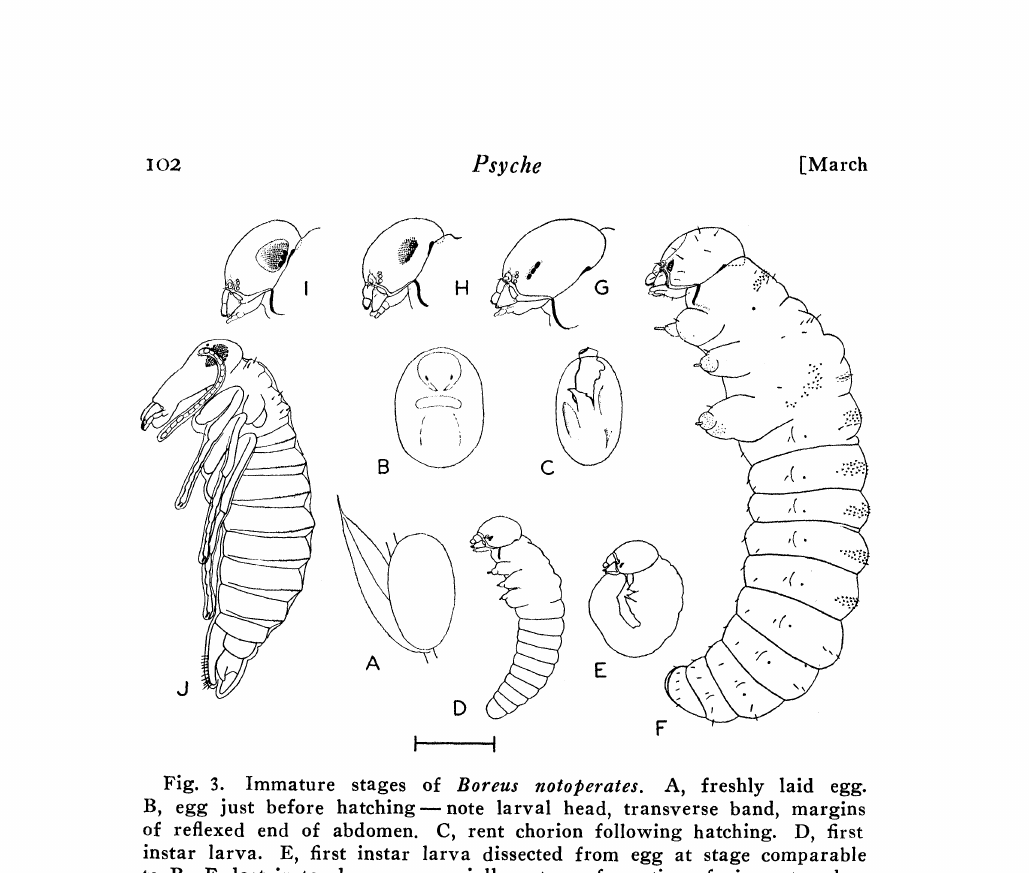
Fig. 3. Immature stages of Boreus nototerates. A, freshly laid egg. B, egg just before hatching--note larval head, transverse band, margins of reflexed end of abdomen. C, rent chorion following hatching. D, first instar larva. E, first instar larva dissected from egg at stage comparable to B. F, last instar larva--especially note conformation of pigment under- lying stemmata (KOH preparation). G to I, pharate pupal heads mnote change in both position and conformation of eye pigment, and its relation to the development of the imaginal eye. J, pharate adult female--note connections between imaginal fixed setae of gonapophyses and corresponding setae of pupal exuvium. Scale- 0.5 ram, applies to figs. F through I; scale--1 mm for J; for dimensions of eggs and first instar larvae, see